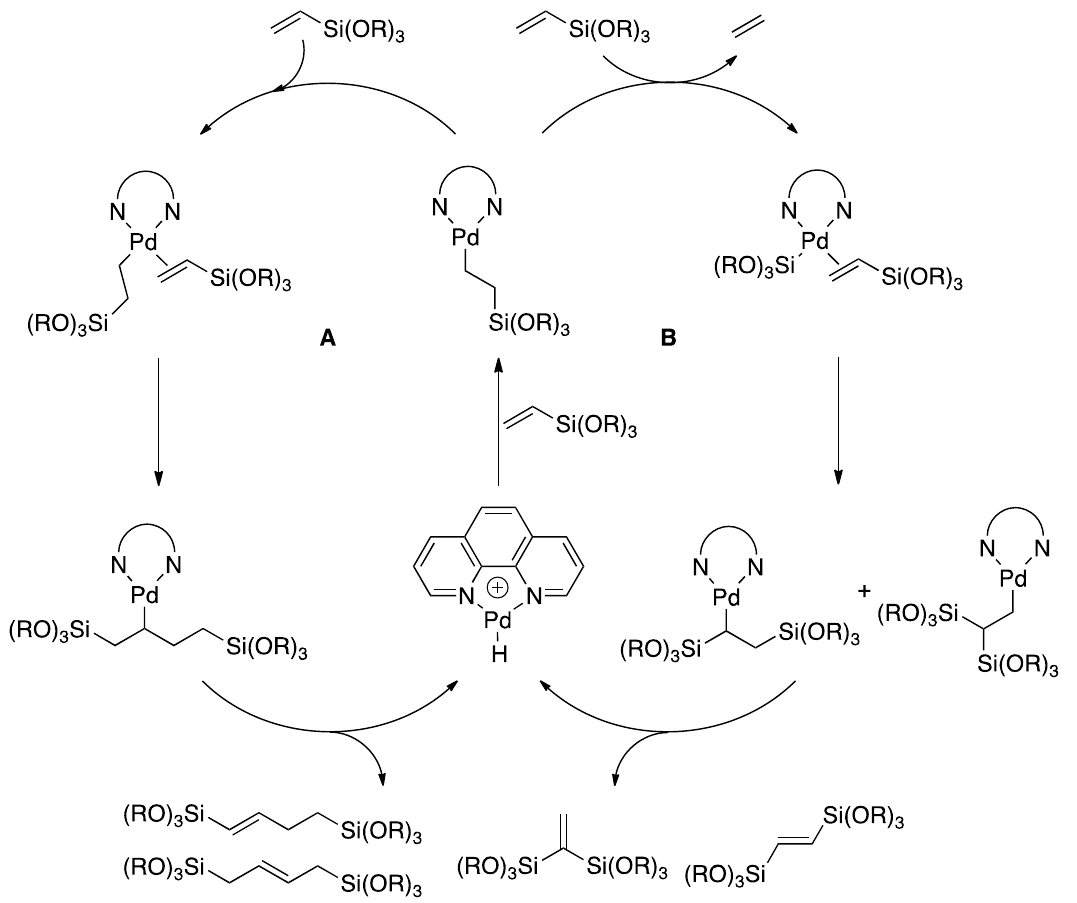
Scheme 6. Proposed mechanism of dimerization and disproportionation to account for product distribution.